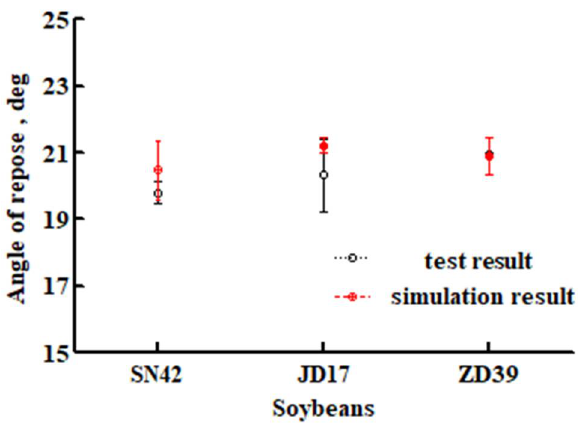
Figure 6. Comparison of simulation and test results of angle of repose.